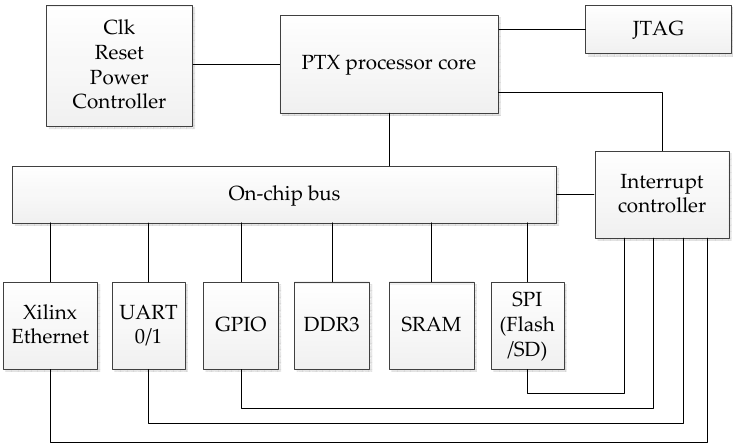
Figure 6. The block diagram of PNX processor pipeline